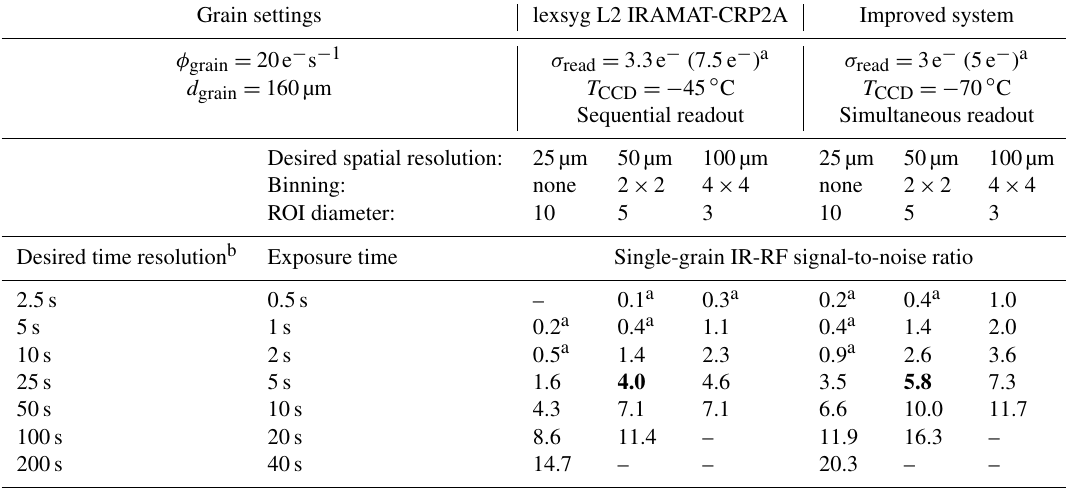
Table A5. Decision table for best binning and channel time settings. We compare the system used in our study and a (hypothetical) sim- ilar system with comparable new camera and improved control software. Bold SNR values are related to the high SNR camera settings, recommend in Table